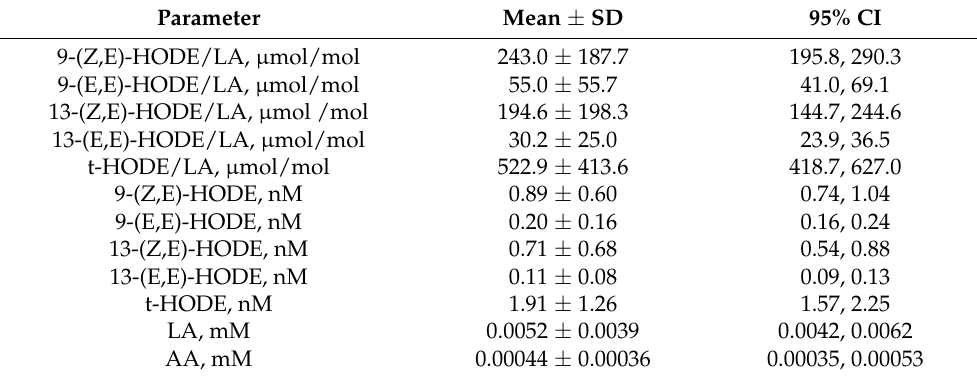
Table 2. HODE levels in